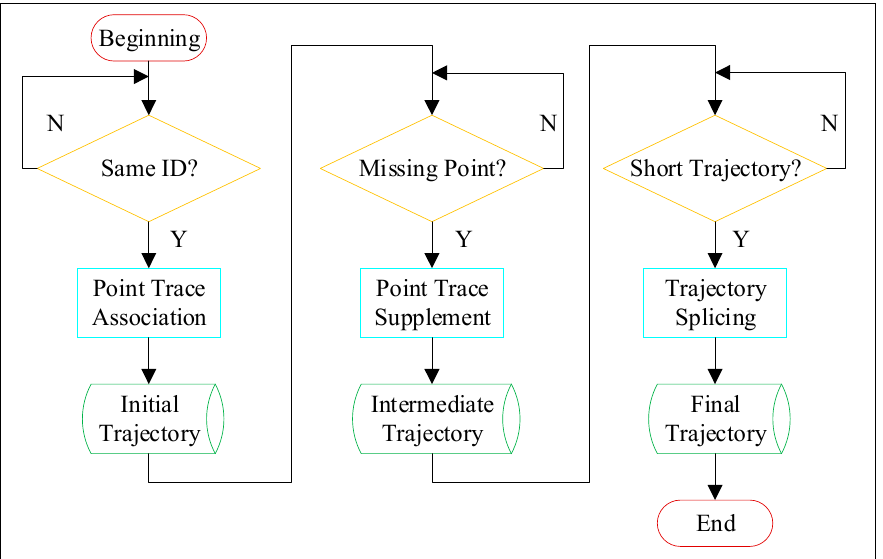
Figure 4. The processing flow of point traces.